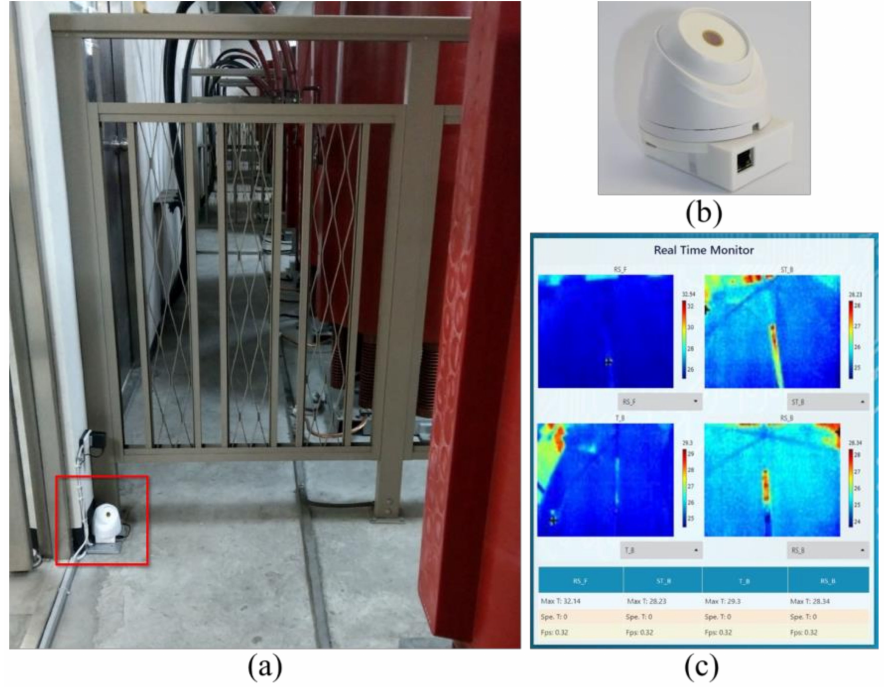
Figure 2. ( a ) The dry-type transformer model. ( b ) The thermal imaging camera, 160 × 120 pixels. ( c ) The interface of condition monitoring